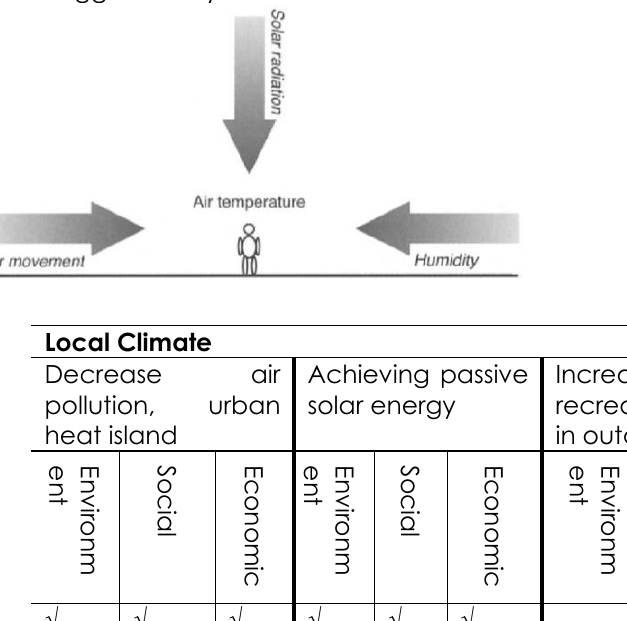
Table 3. Integration between Local Climate Characteristics and Dimension of Sustainability